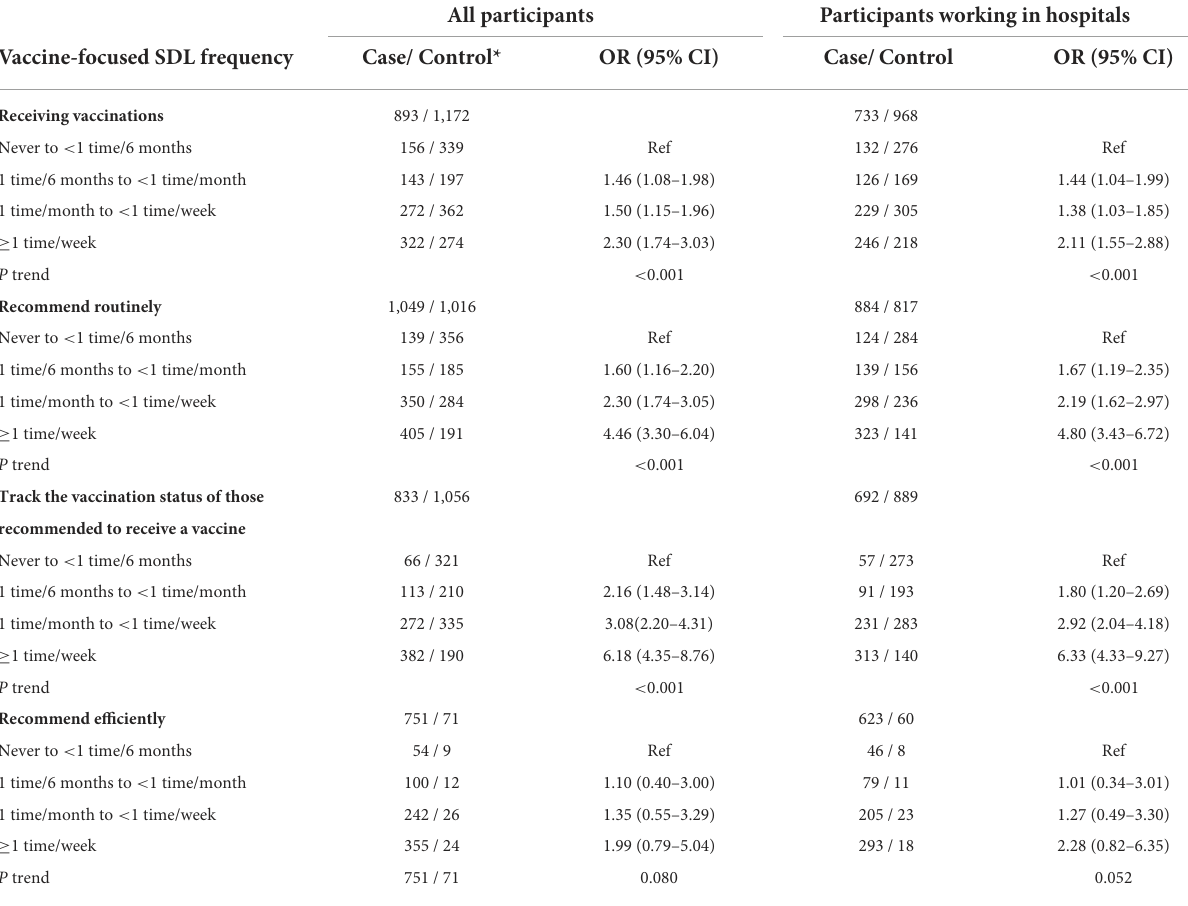
TABLE 2 Associations between vaccine-focused SDL frequency and vaccination-related